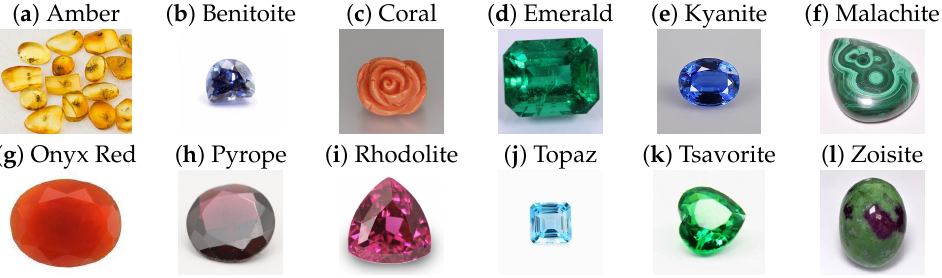
Figure 2. Twelve representative images of the gemstones in this work. It can be noticed that some gems, such as Malachite and Onyx Red, can be readily recognised by the unique colours, whereas it would be challenging to distinguish between Emerald and